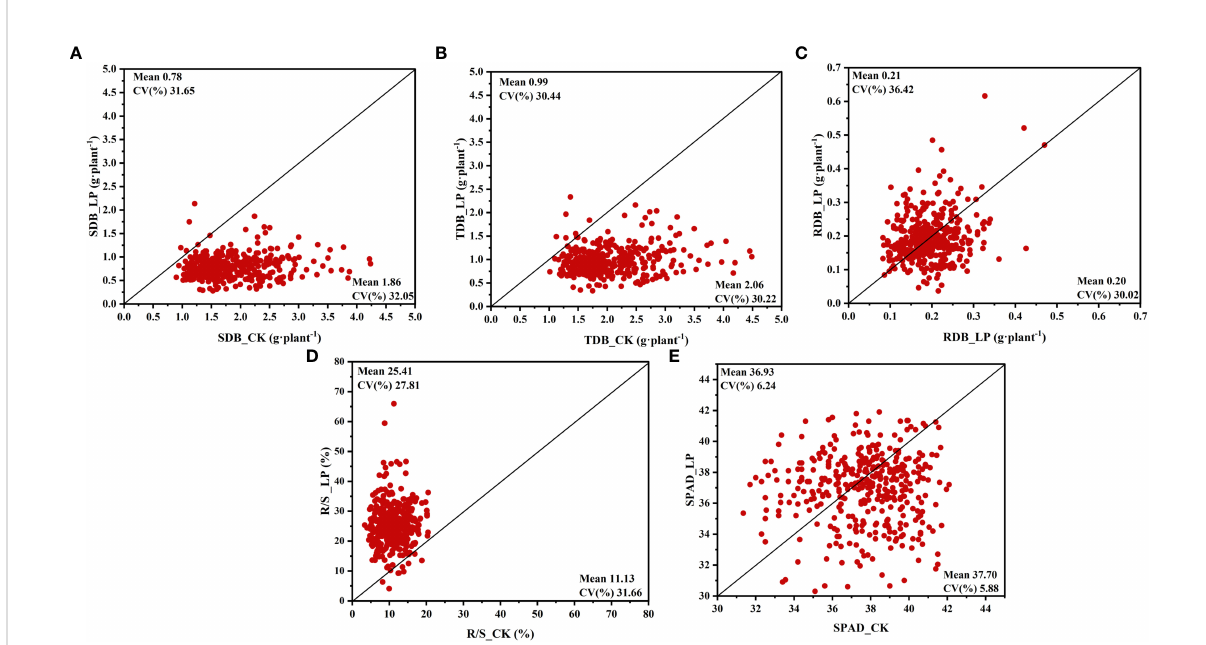
FIGURE 1 Variation in shoot and root fresh and dry weight and root shoot ratio of 384 cotton plants. (A) shoot dry biomass (SDB), (B) total dry biomass (TDB), (C) root dry biomass (RDB), (D) root shoot ratio (R/S), (E) SPAD value (SPAD). The horizontal line in the picture is normal nutrition conditions (CK), and the vertical line is low phosphorus